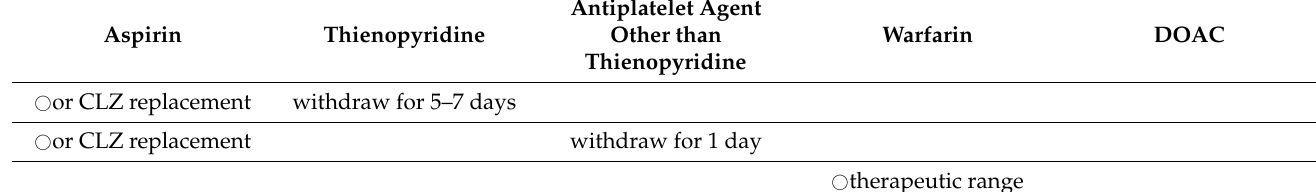
Table 2. Withdrawal of dual therapy with antiplatelet agents or anticoagulants during gastroenterological endoscopy. Antiplatelet Aspirin Thienopyridine